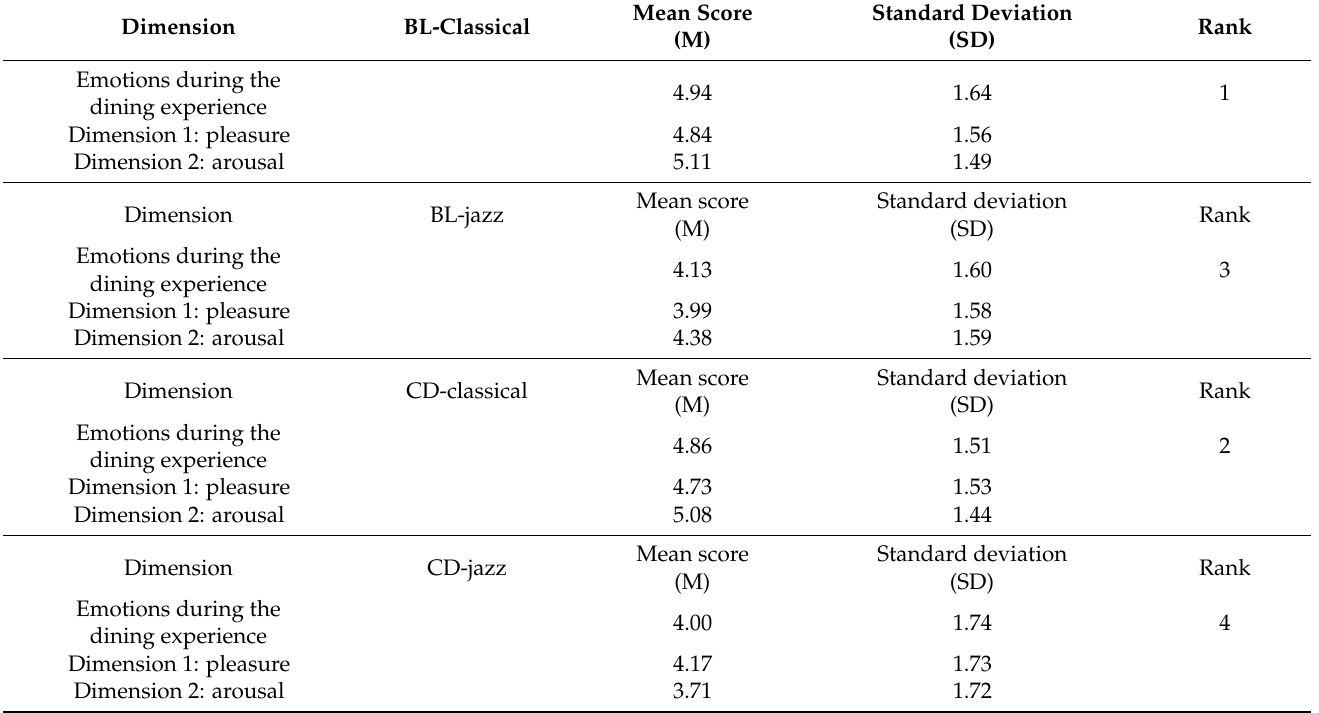
Table 4. Descriptive analysis of the consumers’ emotional responses to different music conditions during their dining experience ( n =